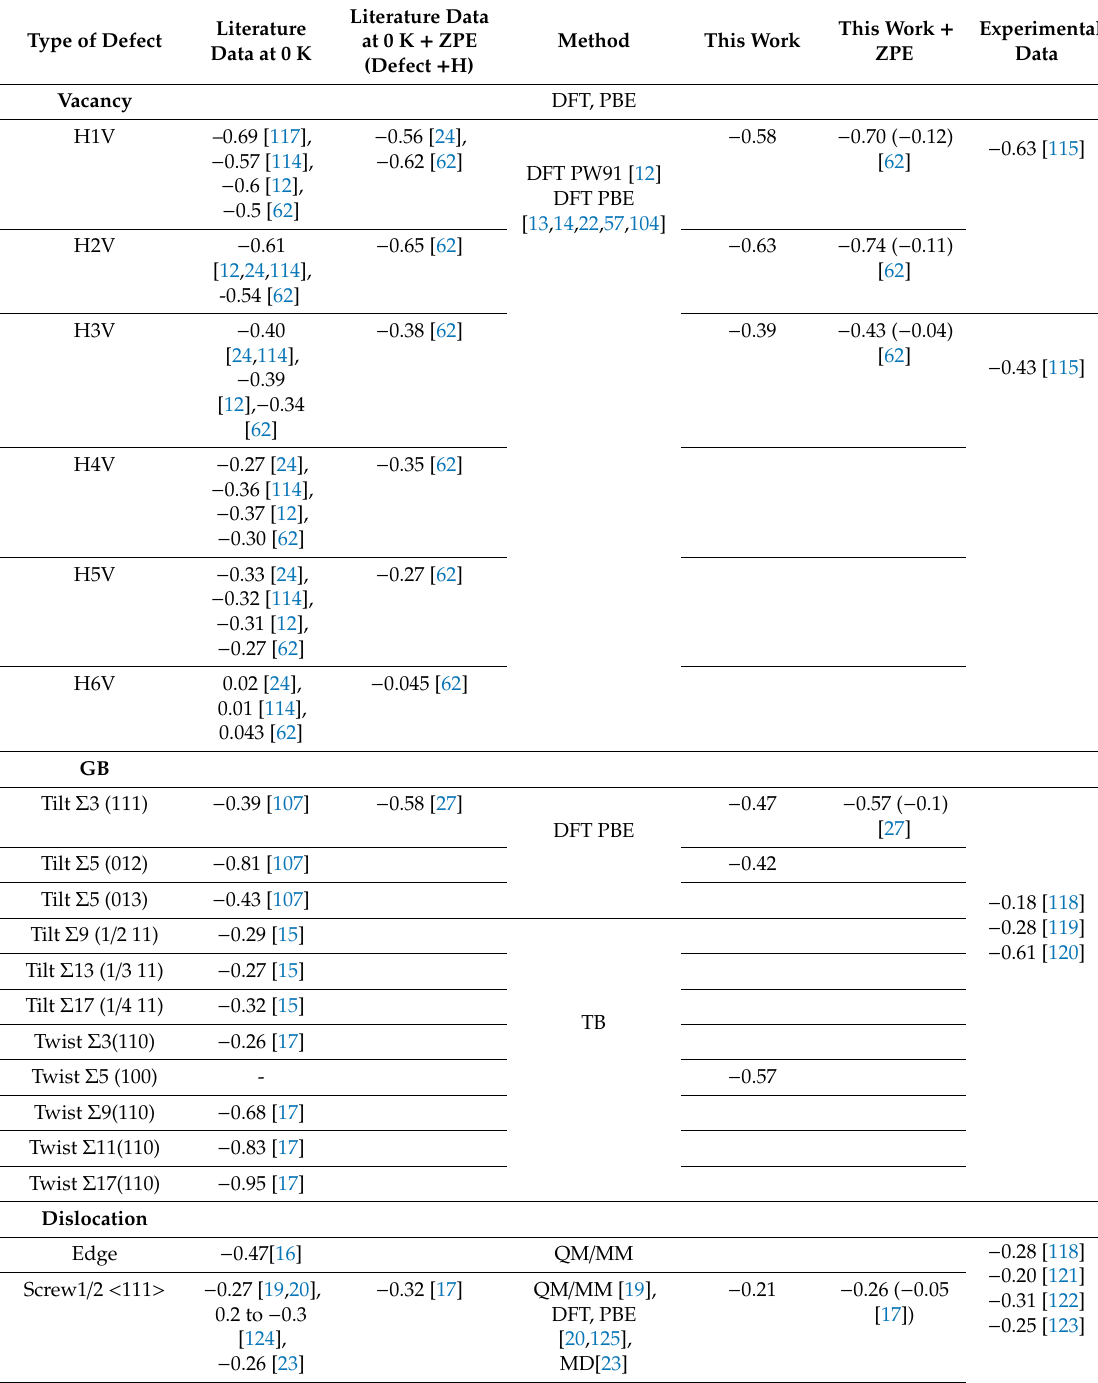
Table 4. H-trapping energies in Fe (in eV / at). Literature data [12–18,23,27] and the results of this work. Zero point energy correction added to the 0 K results has been taken from references [17,27,62], and it is shown in the